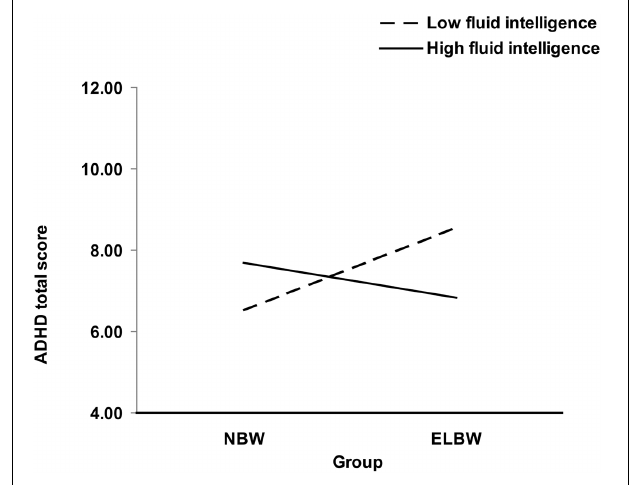
FIGURE 1 | Joint effect of birth weight group and fluid intelligence at age 8 on ADHD total score in young